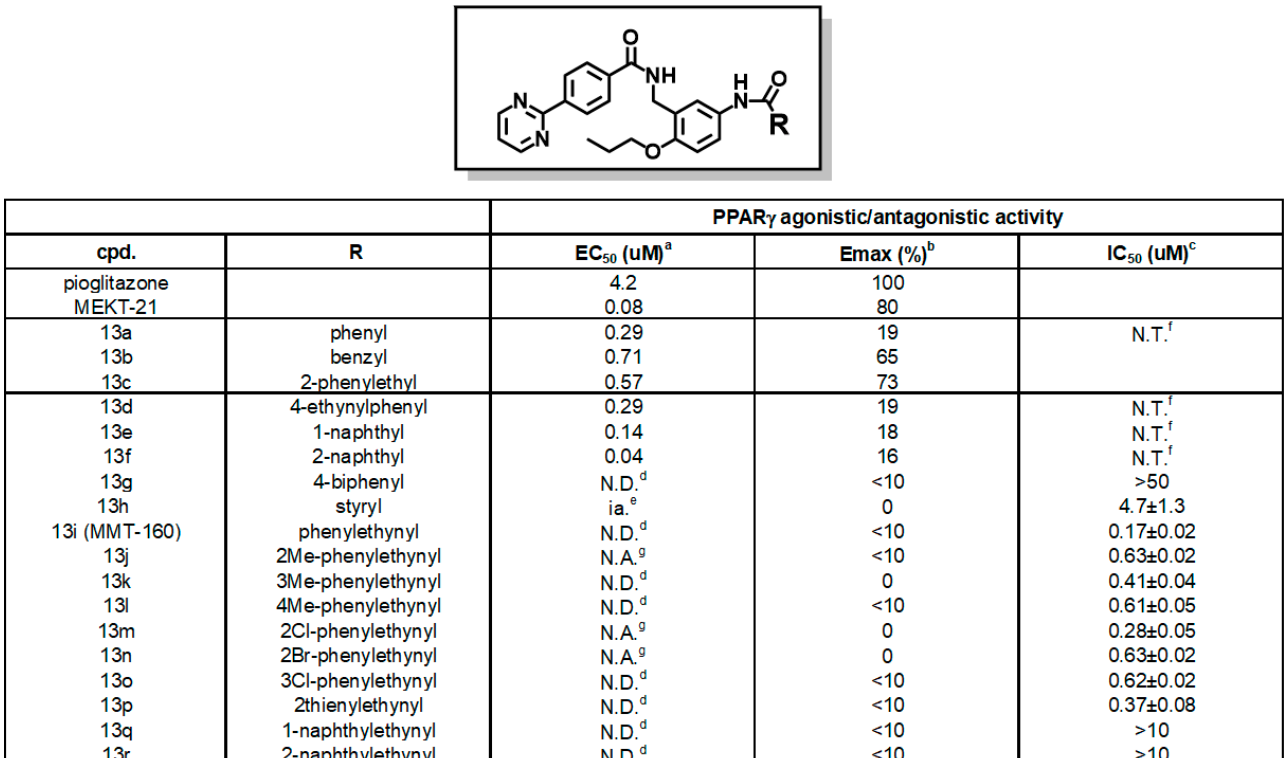
Figure 7. The PPAR γ antagonistic activities of reversed amide derivatives. (a) Half maximal effective concentration. (b) Determined relative to the maximal activity of pioglitazone. (c) Concentration of test compound that afforded a 50% decrease in the maximal activity of pioglitazone (30 μ M). (d) Not determined. (e) Inactive at 10 μ M. (f) Not tested. (g) No activity at 30 μ M.